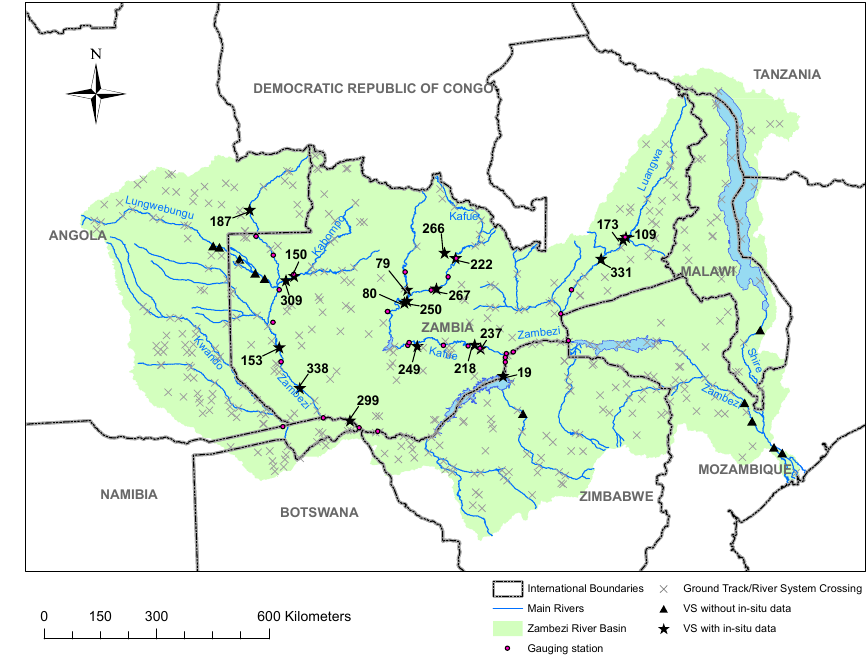
Fig. 1. Location of the virtual stations and monitoring stations with data past the year 2002 in the